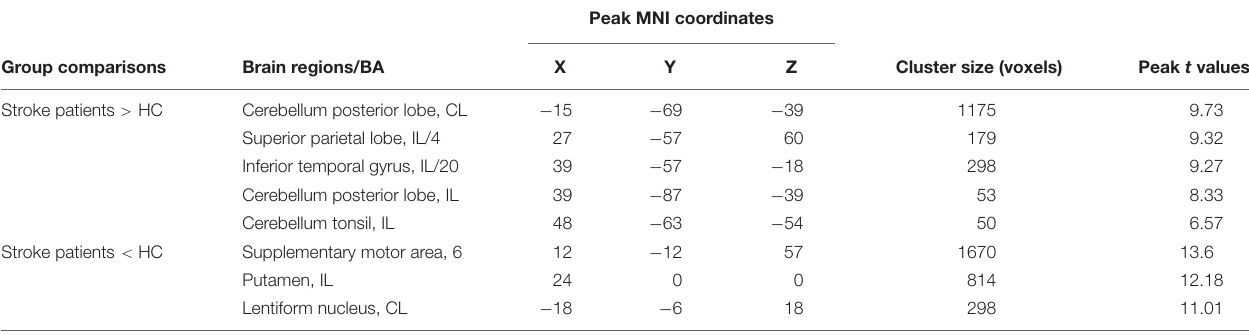
TABLE 2 | Brain regions with significant differences in dynamic ALFF between groups.